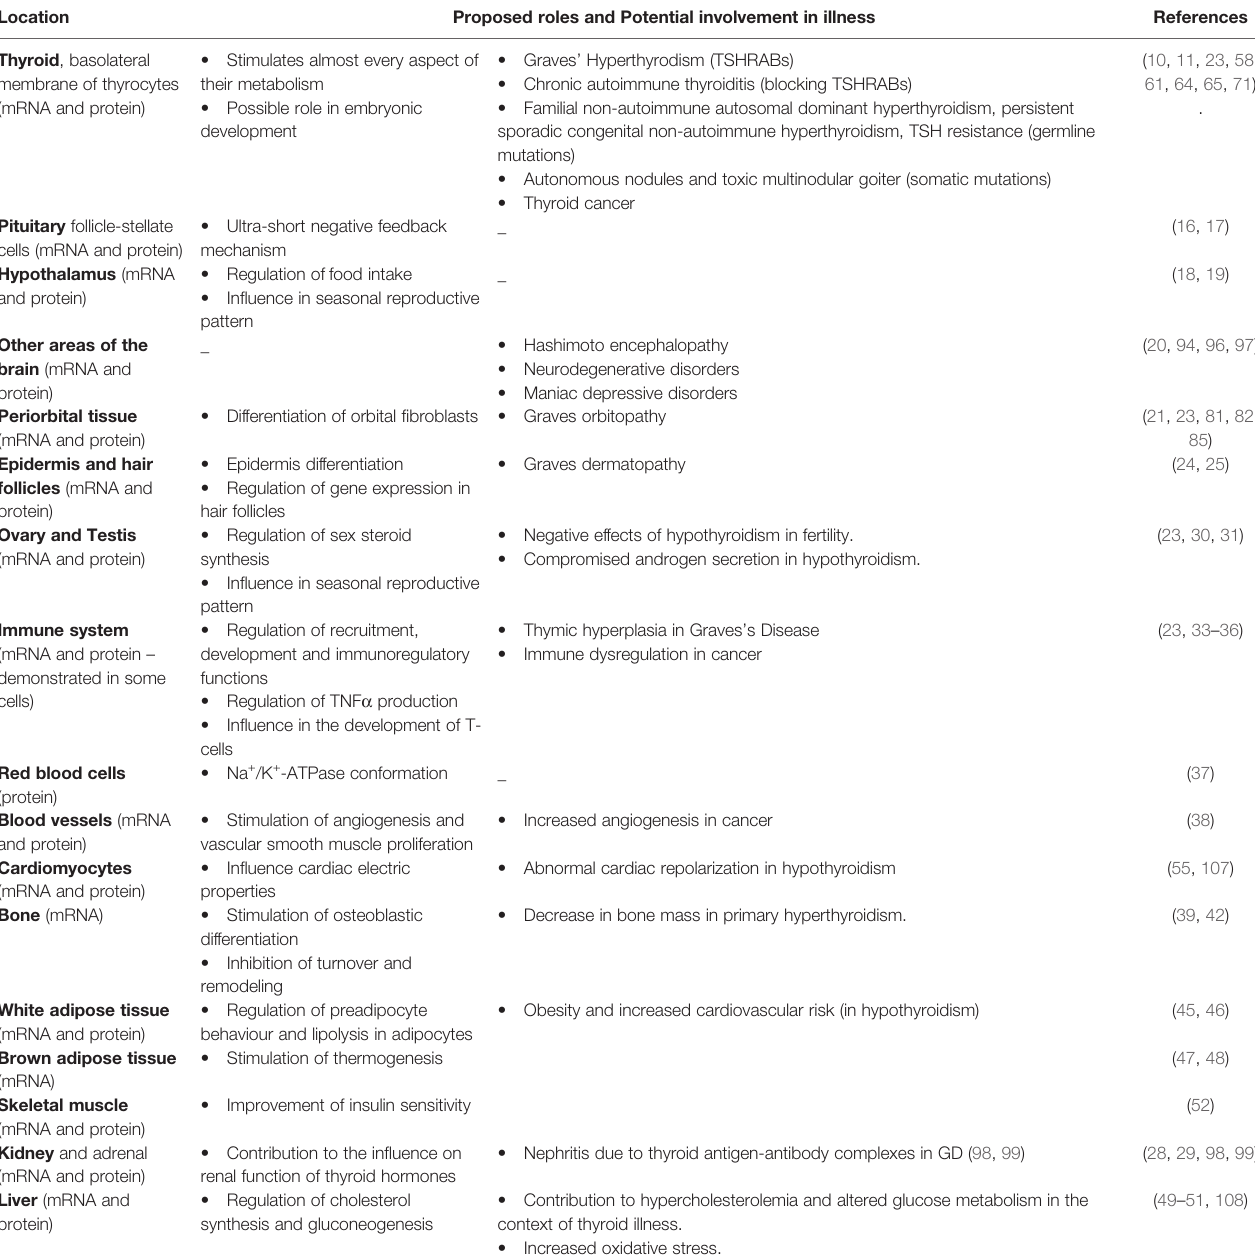
TABLE 1 | Locations of TSH-R and its potential in fl uence on human disease.